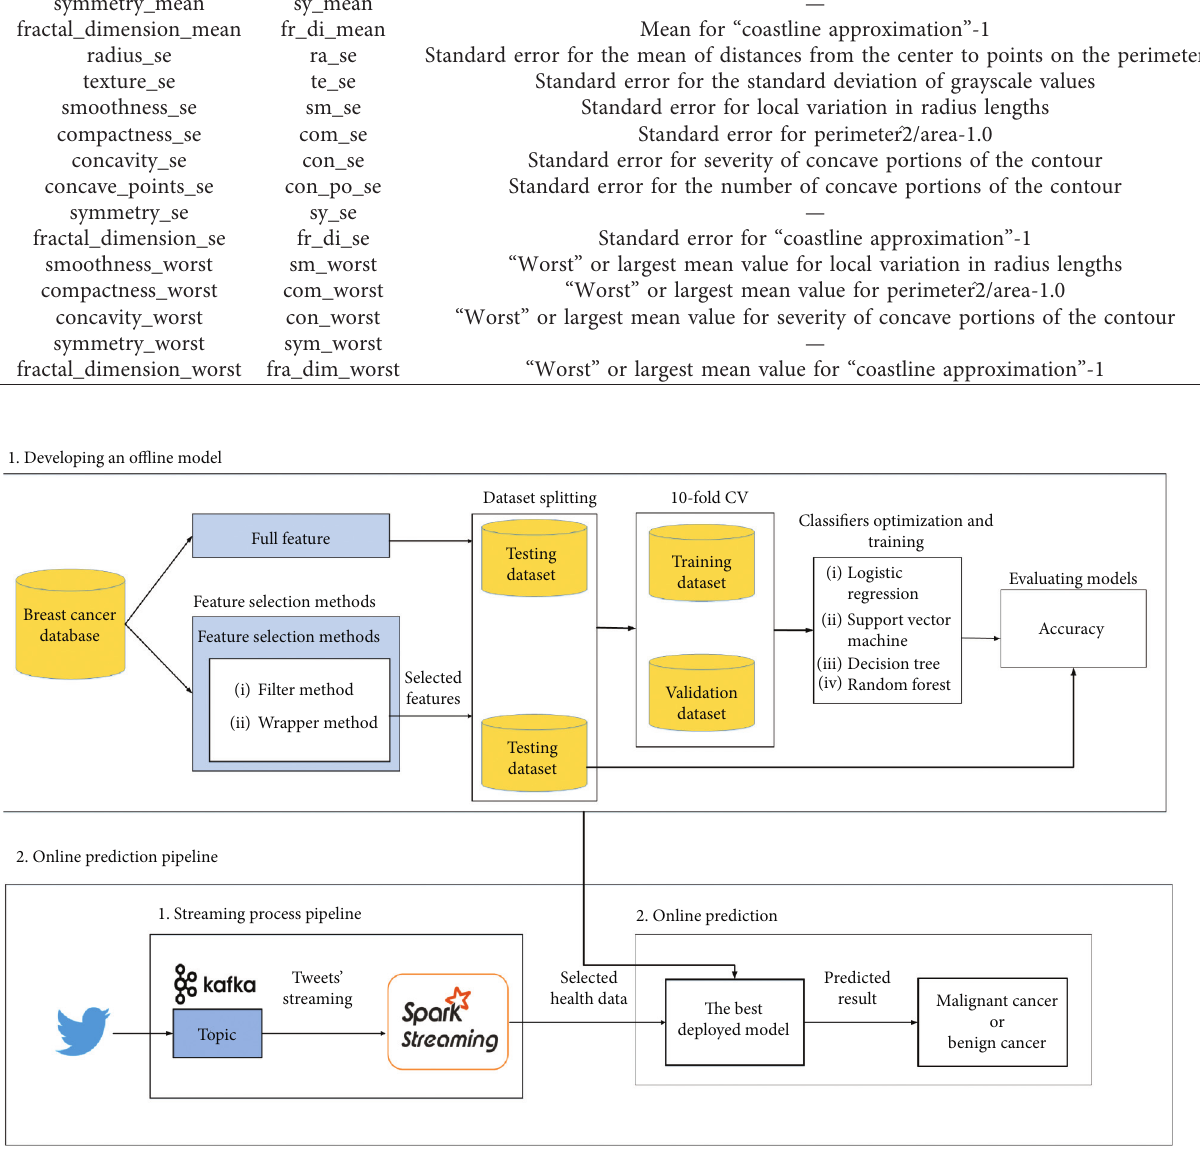
Figure 1: A hybrid intelligent system framework predicting breast cancer disease.